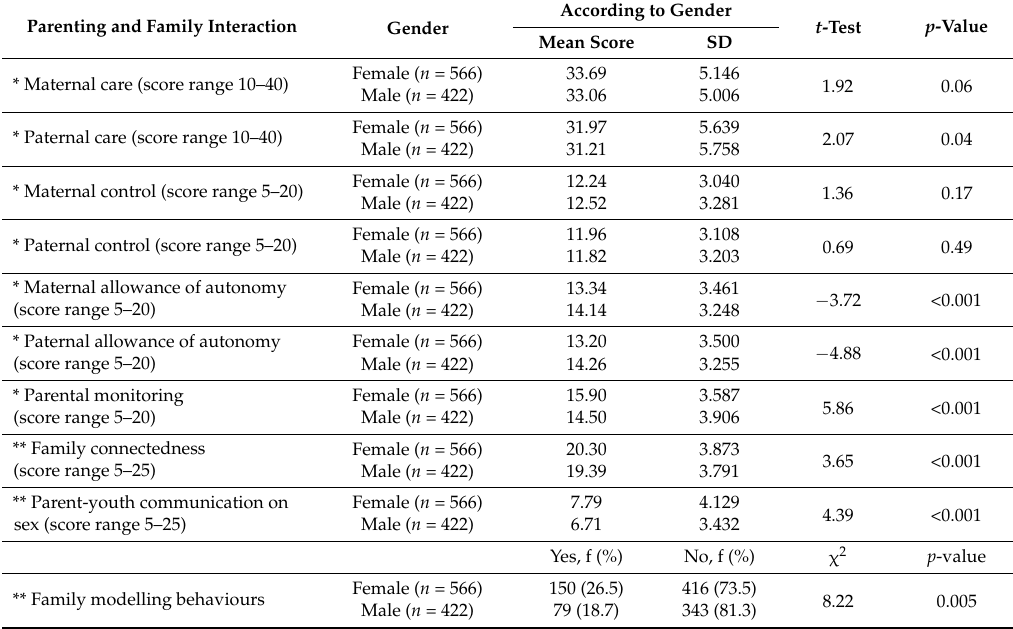
Table 2. Bivariate analysis for family interaction and parenting behaviours for male and female youths. Parenting and Family